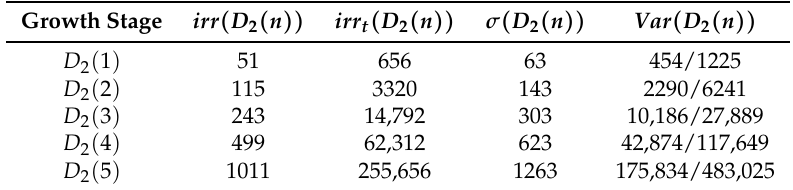
Table 2. The values of irregularity indices of structure of PETAA dendrimers against different generation stages.